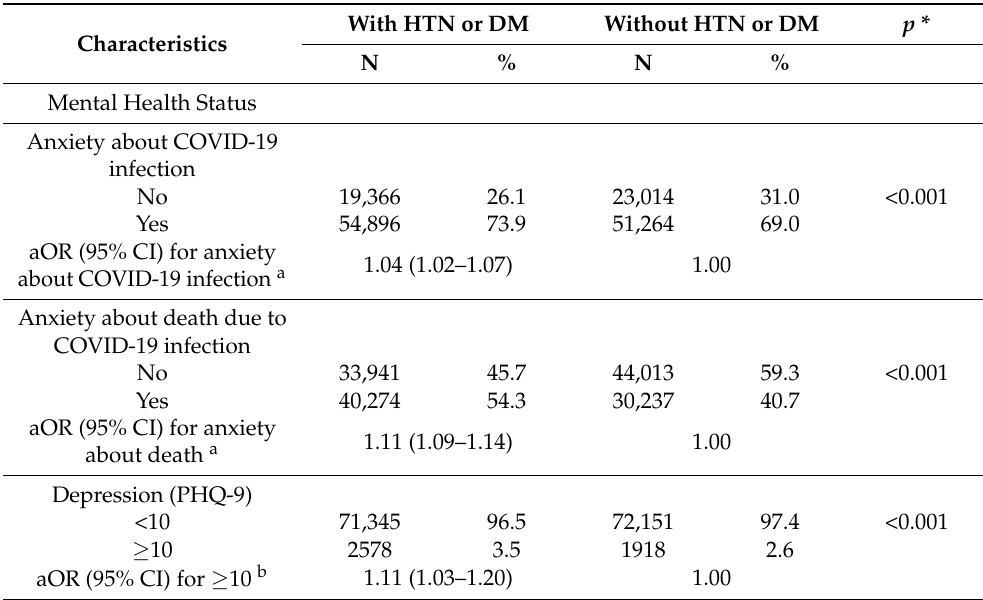
Table 2. Mental health status during the COVID-19 pandemic among people with HTN and DM compared to